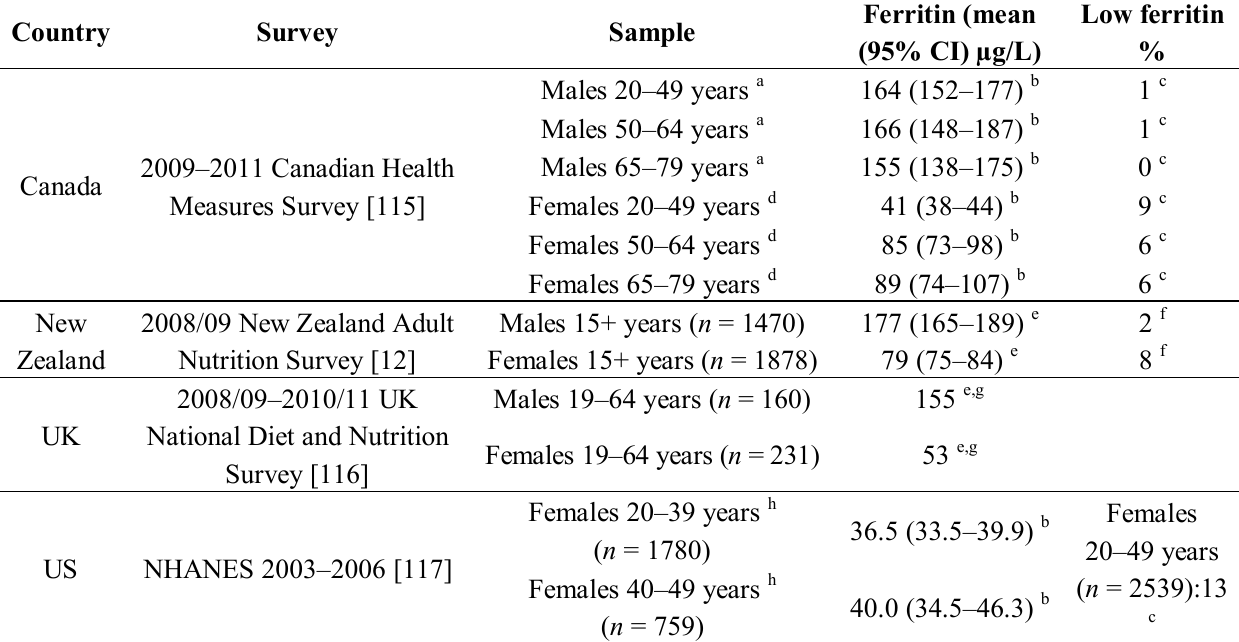
Table 6. Measurements of ferritin and prevalence of low ferritin in national